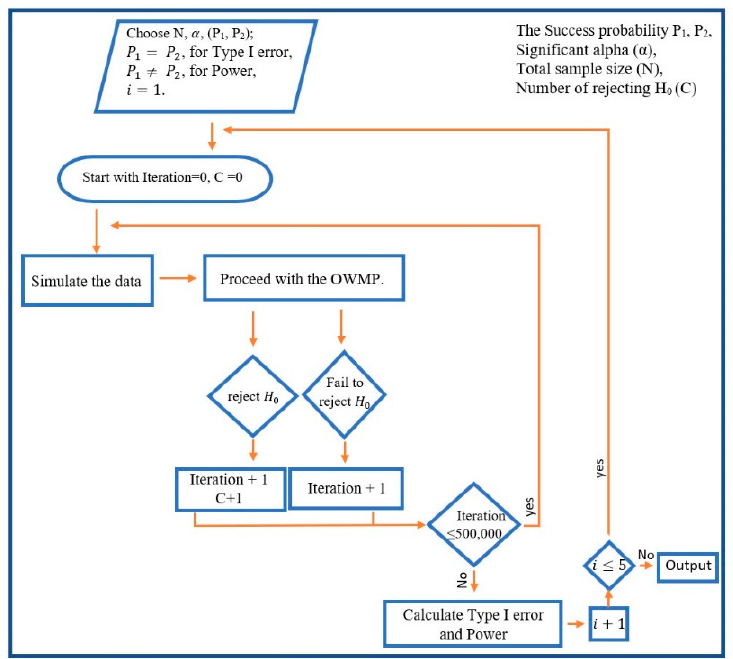
Figure 2. The algorithm for the optimal weighted multiple—testing procedure.